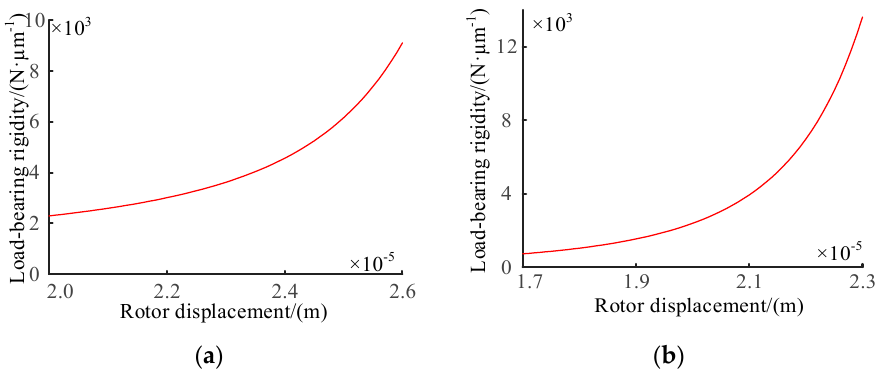
Figure 11. Stiffness-displacement curve. ( a ) is total stiffness of bearing system before oil film thickness change, ( b ) is total stiffness of bearing system after oil film thickness change.